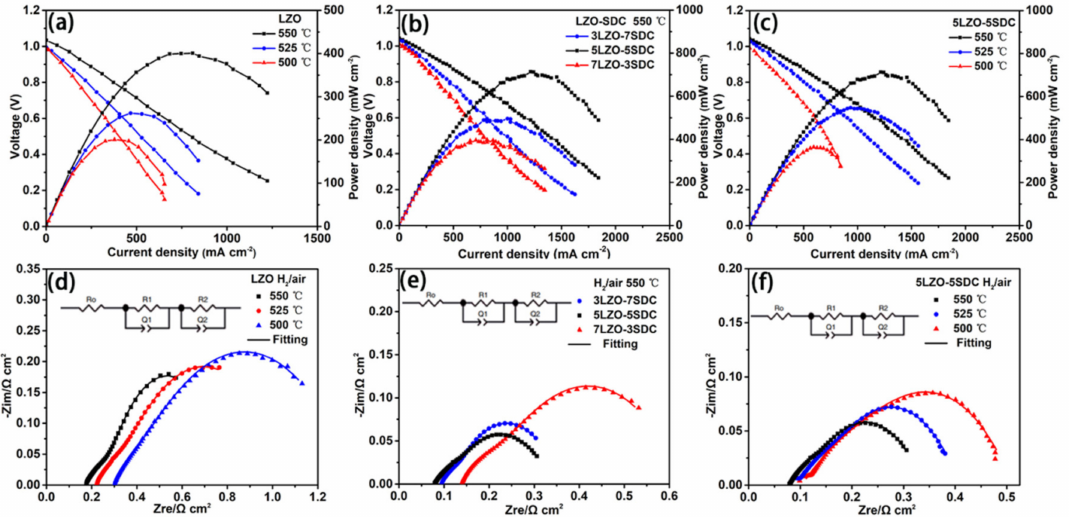
Figure 3. Electrochemical performance of ( a ) LZO SOFC at 500–550 ◦ C, ( b ) LZO-SDC SOFCs with various compositions at 550 ◦ C, and ( c ) 5LZO-5SDC SOFC at 500–550 ◦ C; the corresponding EIS for ( d ) LZO SOFC, ( e ) LZO-SDC SOFCs with various compositions, and ( f ) 5LZO-5SDC SOFC measured in H 2